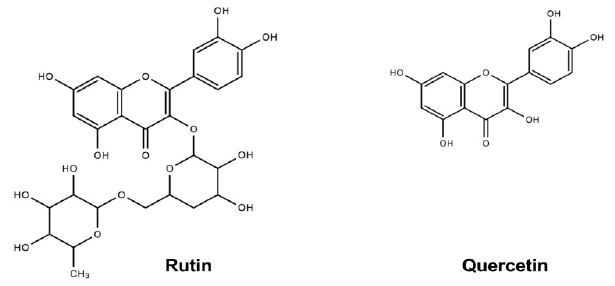
Figure 1. Chemical structures of rutin and